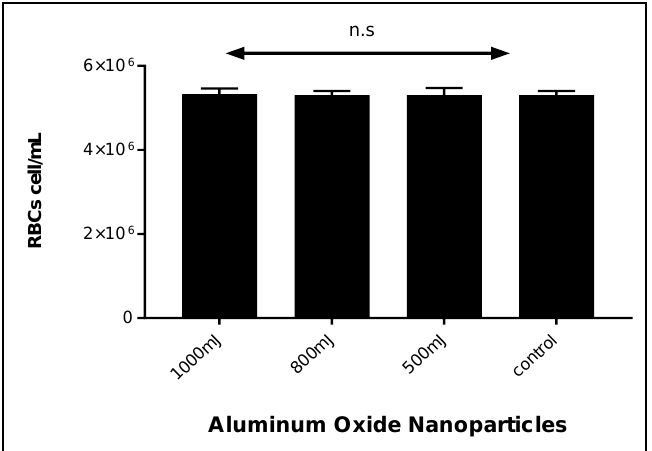
Figure 7: Platelet’s count level in blood samples in the presence and absence of Al 2 O 3 NPS at different energy (500, 800, and 1000) mJ.